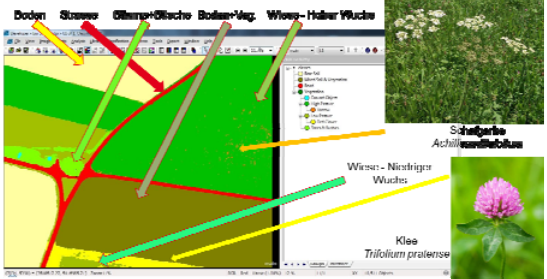
Figure 17: UAV imagery – result of classification (Source. Chaudry, 2015).